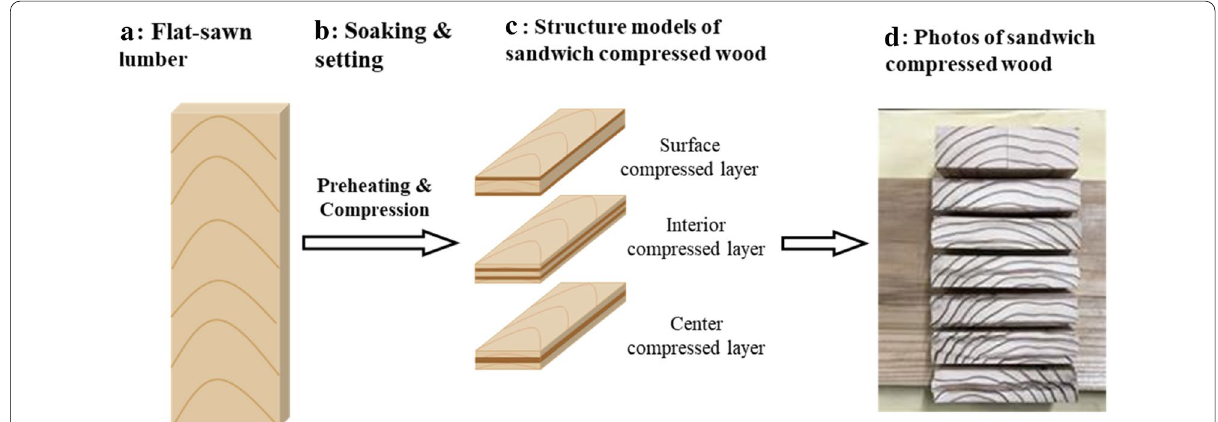
Fig. 1 Schematic diagram for sample preparation and sandwich compression